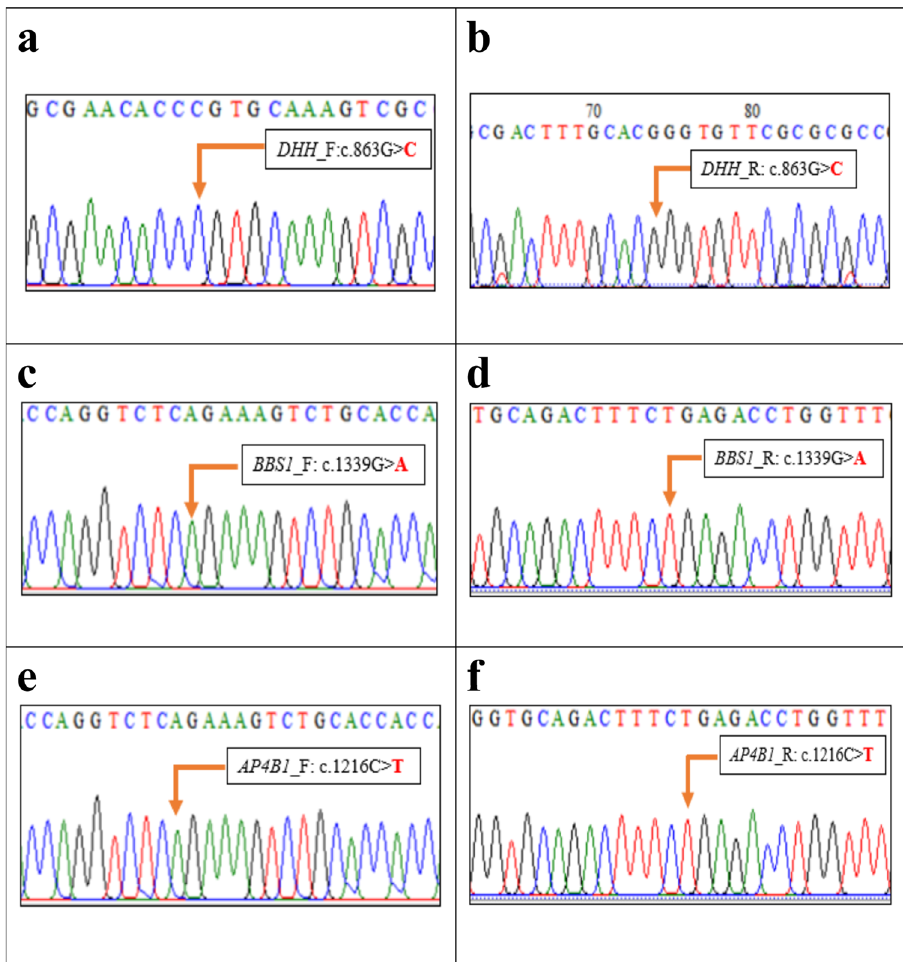
Fig. 2 Sanger validation of all homozygous mutations in DHH , BBS1 and AP4B1 genes. a , b Forward and reverse strand sequence of novel homozygous missense mutation c.863 G > Cin DHH gene (Patient-1). c , d Forward and reverse strand sequence of homozygous missense mutation c.1339 G > Ain BBS1 gene (Patient-3). e , f Forward and reverse strand sequence of homozygous missense mutation c.1216 C > Tin AP4B1 gene